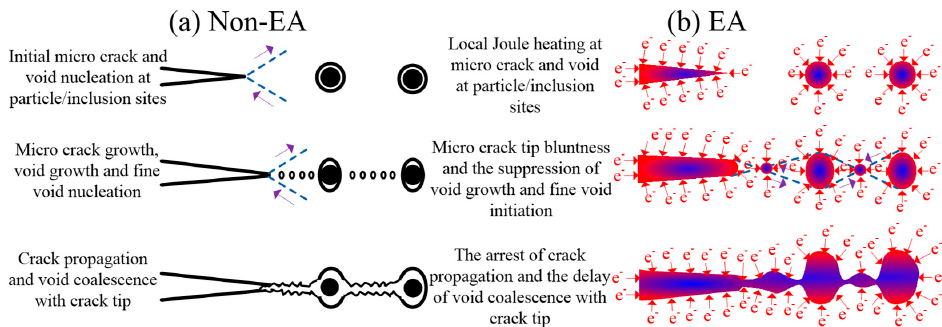
Figure 9. SEM micrographs of the fracture areas for ( a ) RT, ( b ) OH, ( c ) AC, and ( d ) EA.